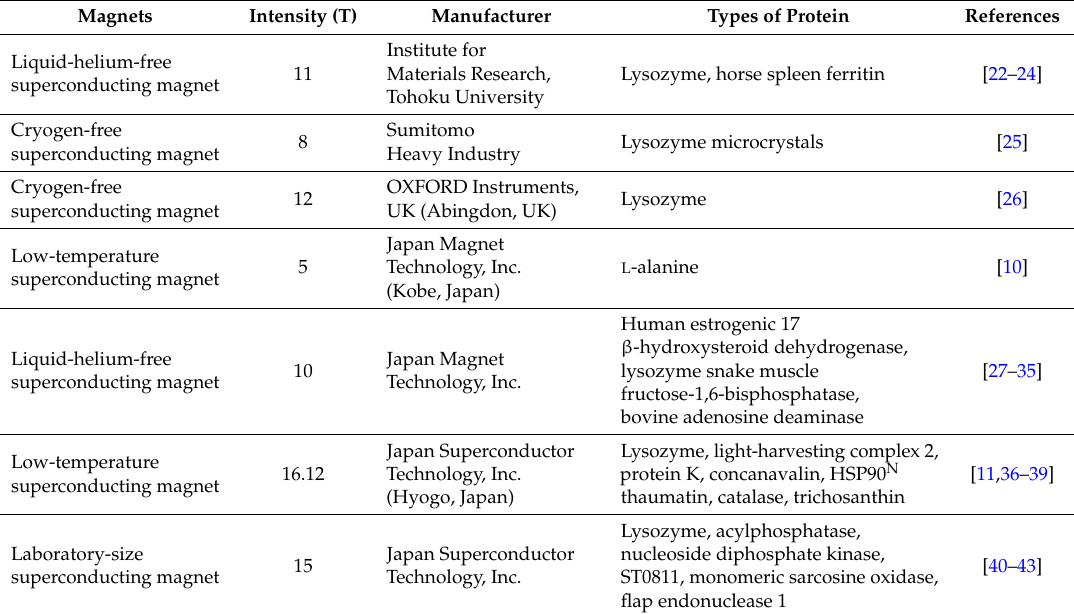
Table 2. Superconducting magnets used for protein crystallization.